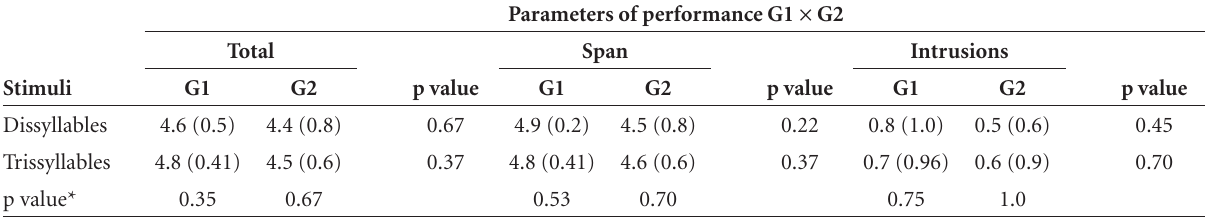
Table 2. Group and stimuli effect*. Inter and intra-groups comparison on N-Back performance